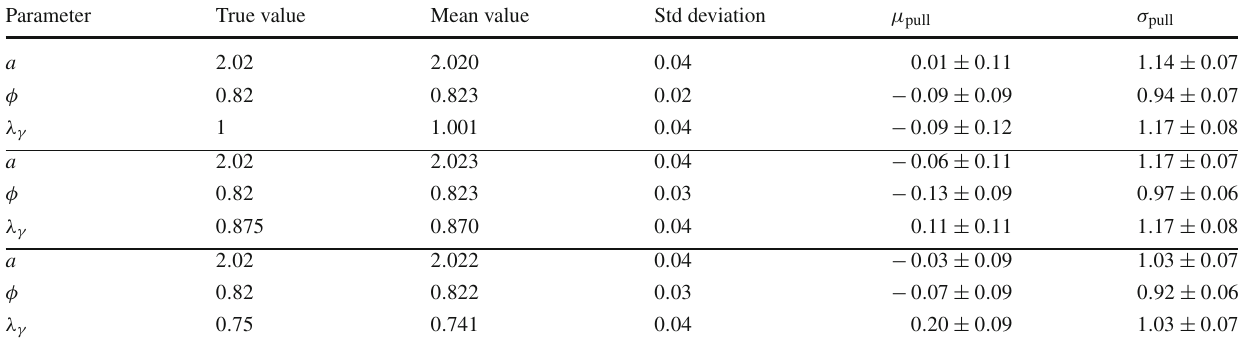
amplitude model composed by K 1 ( 1270 ) + → K + ρ( 770 ) 0 and K 1 ( 1270 ) + → K ∗ ( 892 ) 0 π + . Table 7 lists results of fits on simulated data sets generated with different relative mag- nitudes and phases. Results of fits for models generated with various values of λ γ are shown for two sets of two-amplitude samples corresponding respectively to a region of high up- down asymmetry (relative phase of − 0 . 91) in Table 8 and a region of low up-down asymmetry (relative phase of 0 . 82) in Table